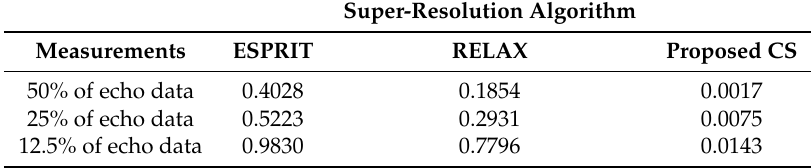
Table 4. MSEs of the estimated position using the ESPRIT, RELAX and proposed CS algorithms under different